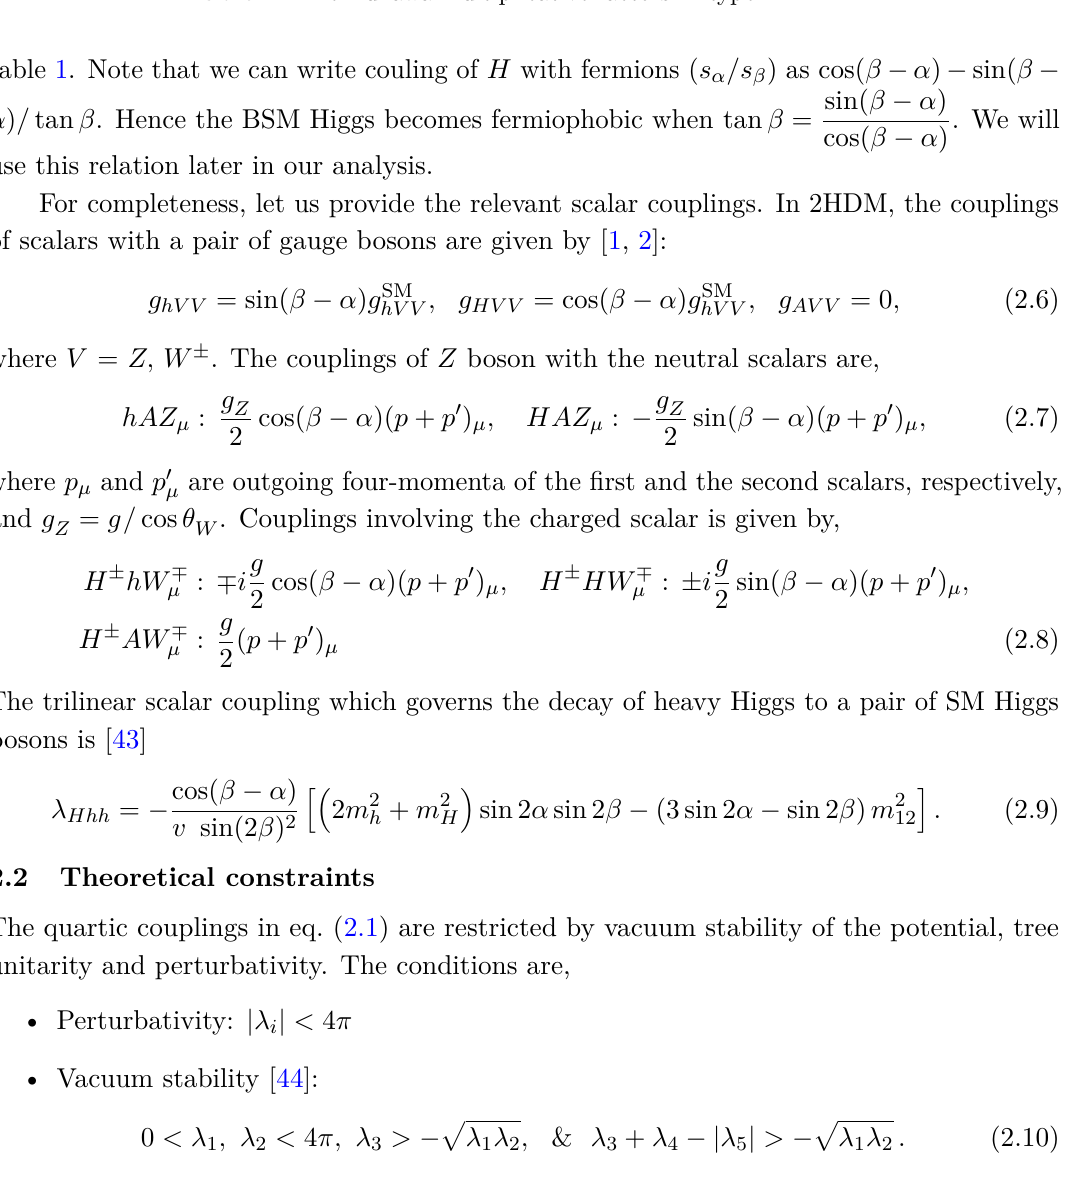
Table 1 . The Yukawa multiplicative factors in type I 2HDM.